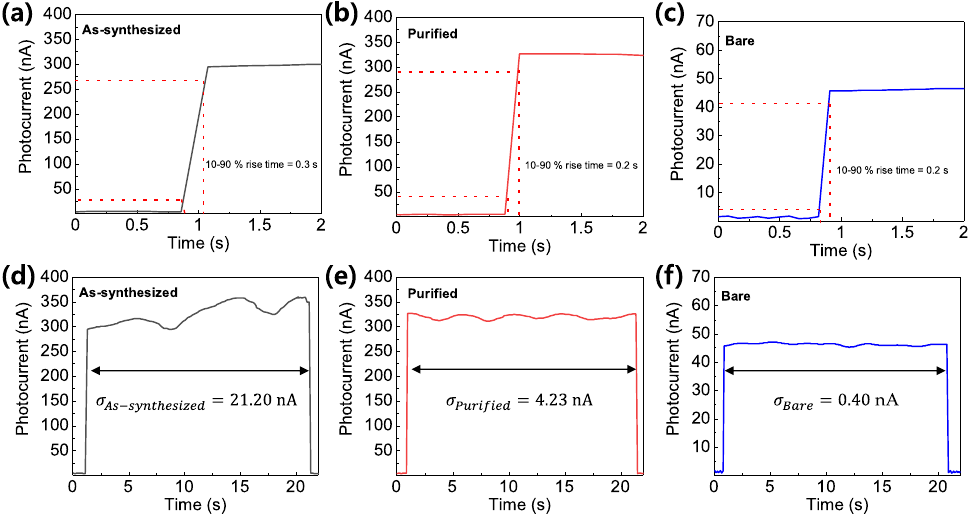
Figure 6. 10 – 90% rise time of ( a ) as-synthesized Au nanorod/2D PtSe 2 , ( b ) purified Au nano- rod/2D PtSe 2 , and ( c ) bare 2D PtSe 2 . Variation in photocurrent of ( d ) as-synthesized Au nano- rod/2D PtSe 2 , ( e ) purified Au nanorod/2D PtSe 2 , and ( f ) bare 2D PtSe 2 .